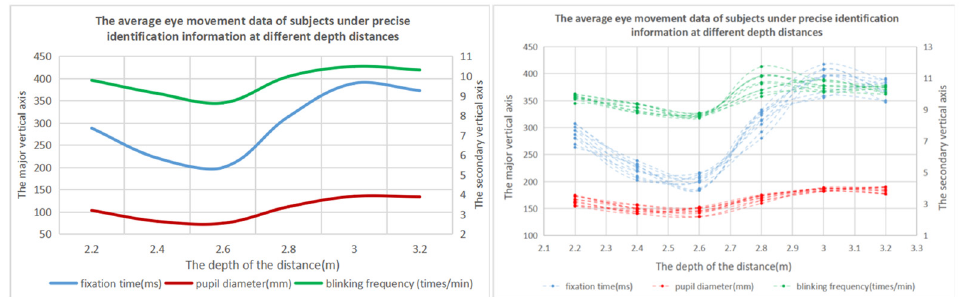
Figure 10. Variation trend diagram of eye movement data with different depths and distances of the accurate identification information.